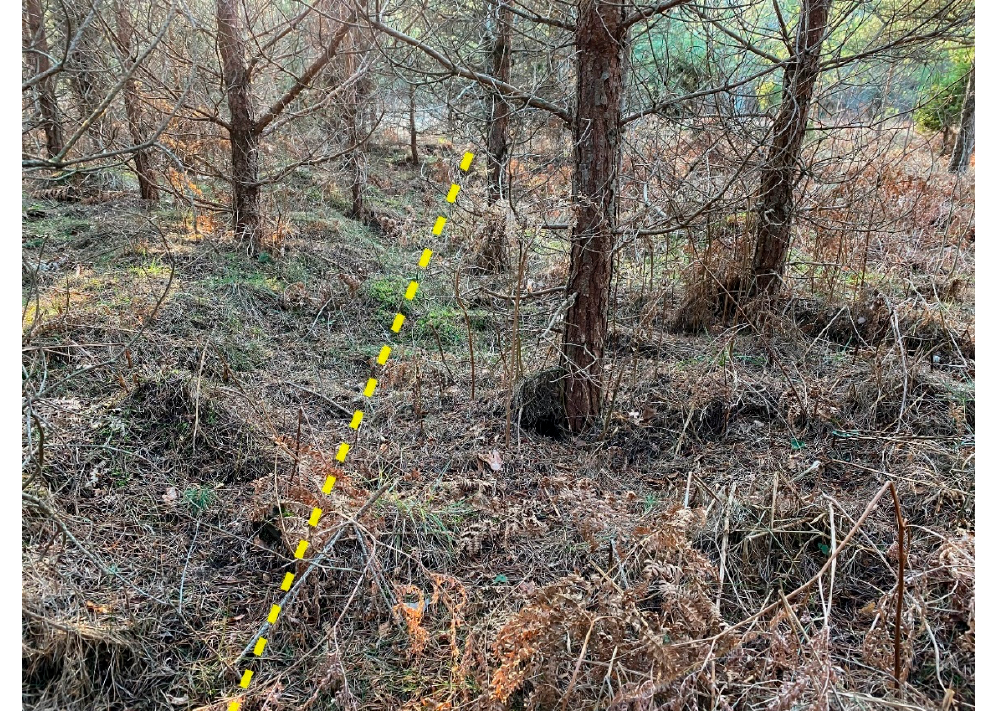
Figure 9. Sundre parish, Gotland. The yellow line marks the lower edge of an earthwork (i.e., field enclosure). The earthwork is approximately 0.4 m high and about 7–8 m wide. Such features might be hard to detect during forestry. This part of the field system was subjected to reforestation a few decades ago. Photo: Daniel Langhammer, 2020.